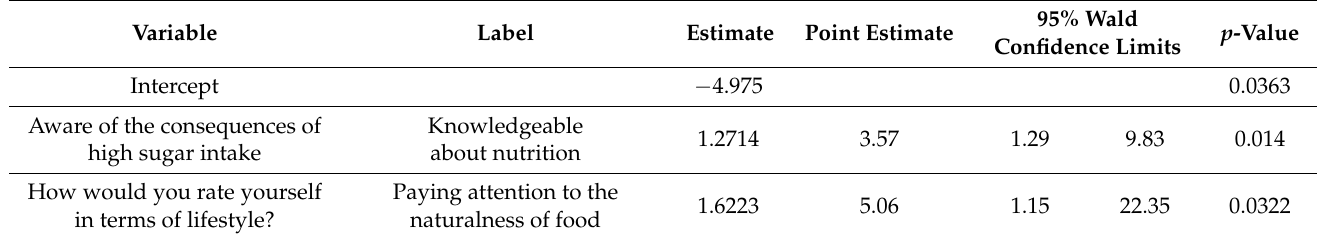
Table 5. Declaration of noticing “light” products on the